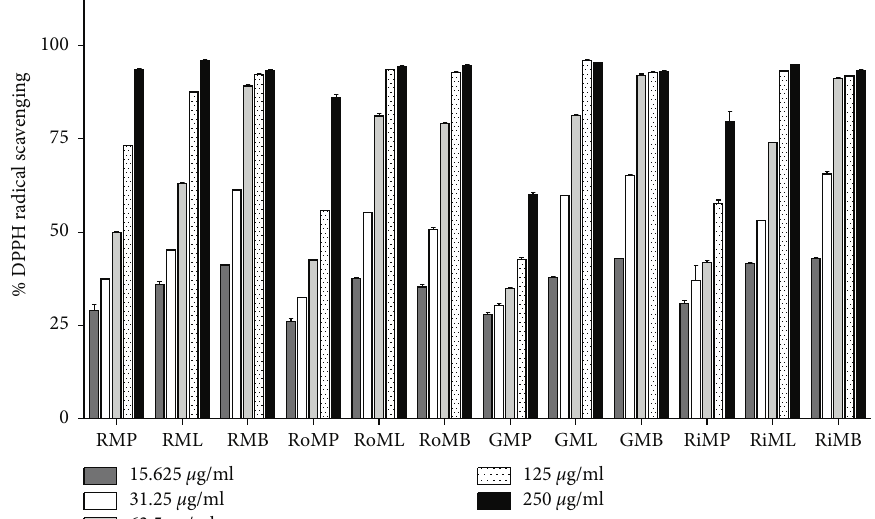
Figure 5: Bar diagram showing DPPH free radical scavenging capacities of peel, leaf and stem bark extract of four different M. domestica cultivars from